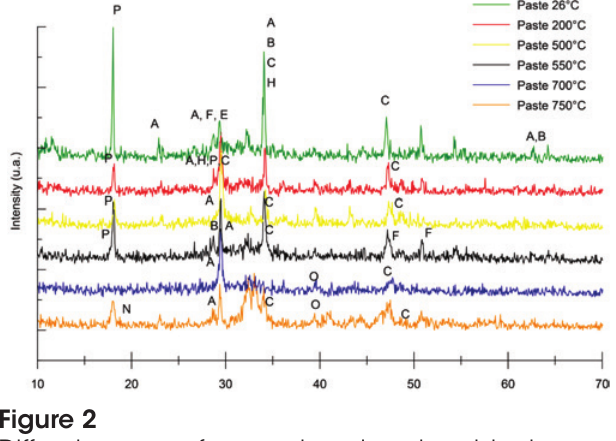
Figure 2 Diffractograms of cement pastes at ambient temperature (26 °C) and thermal treatments: 200, 500, 550, 700 °C, and 750 °C. Labeled peaks: tricalcium silicate (A), bicalcium silicate (B), calcium carbonate (C), calcium aluminum hydrosulfate (E), tetracalcium sulfoaluminate (F), calcium silicate hydrate (H), calcium hydroxide (P), new silicate (N), calcium oxide (O)